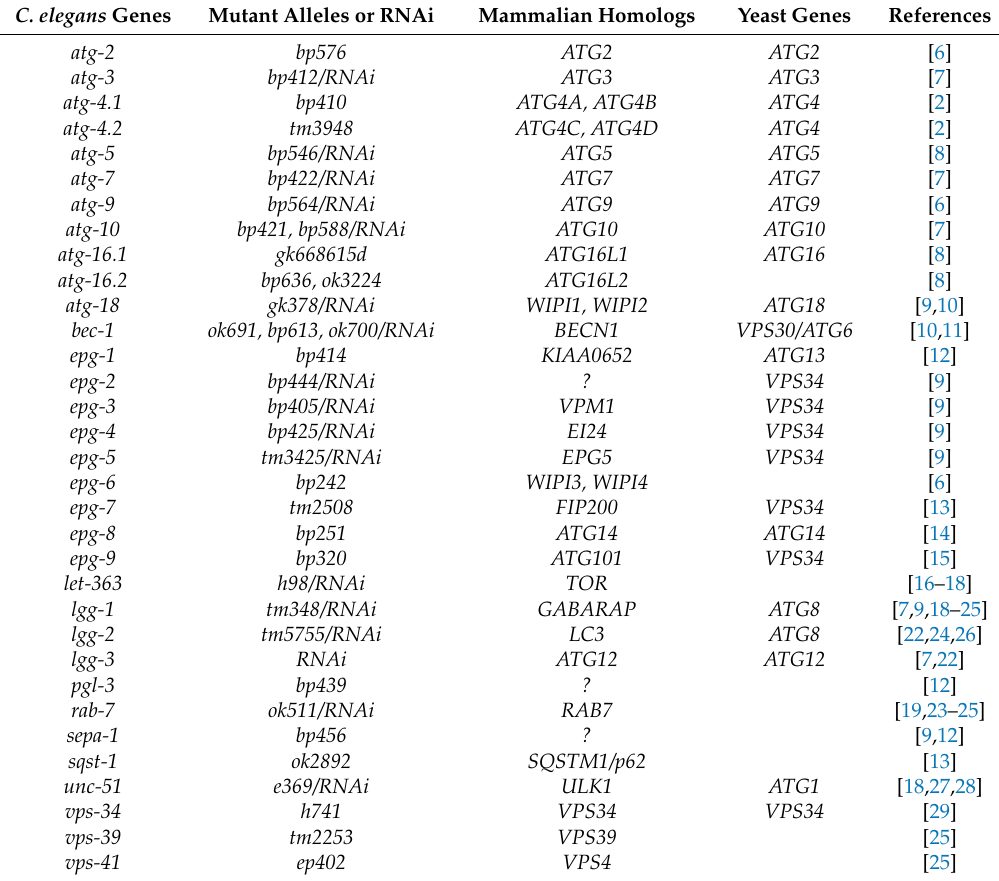
Table 1. Autophagy genes in C. elegans , and